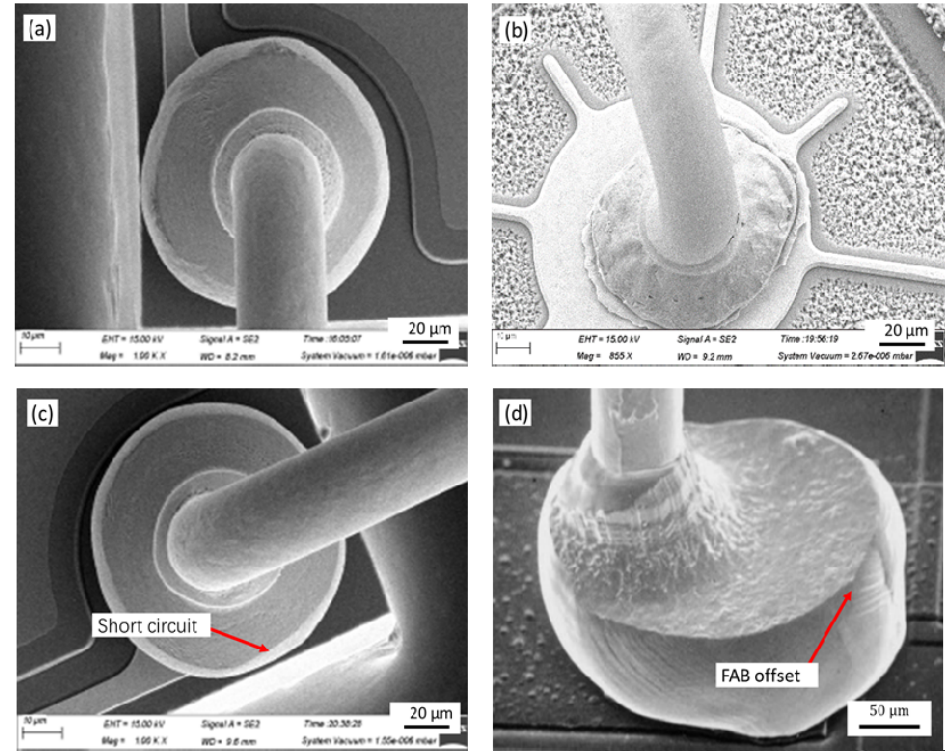
Figure 10. The morphology of the ball bonded points ICBAs of: ( a ) 100°; ( b ) 70°; ( c ) 120°; ( d ) the ICBA is so small that it forms an eccentric ball.